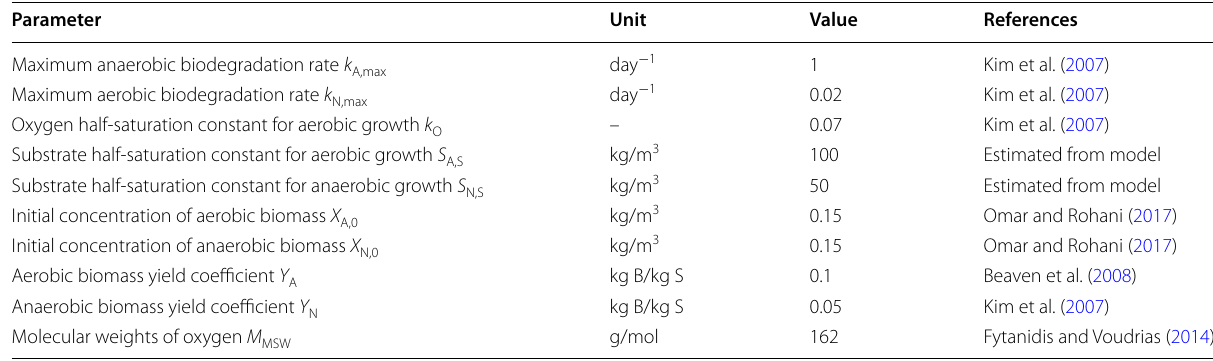
Table 2 Biokinetic parameters used in this paper Parameter